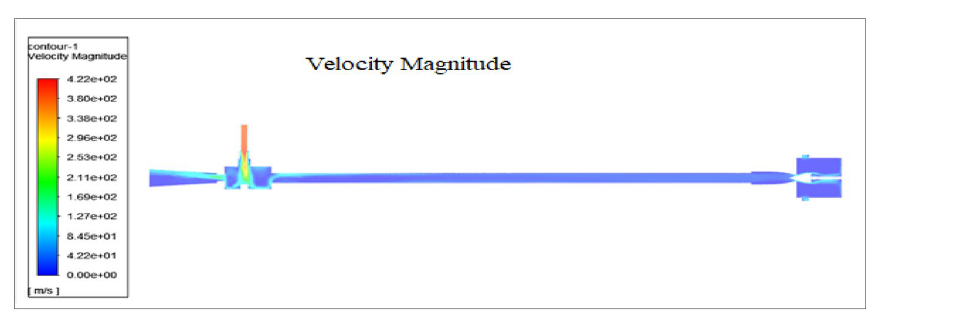
Figure 63. Velocity magnitude of the vortex